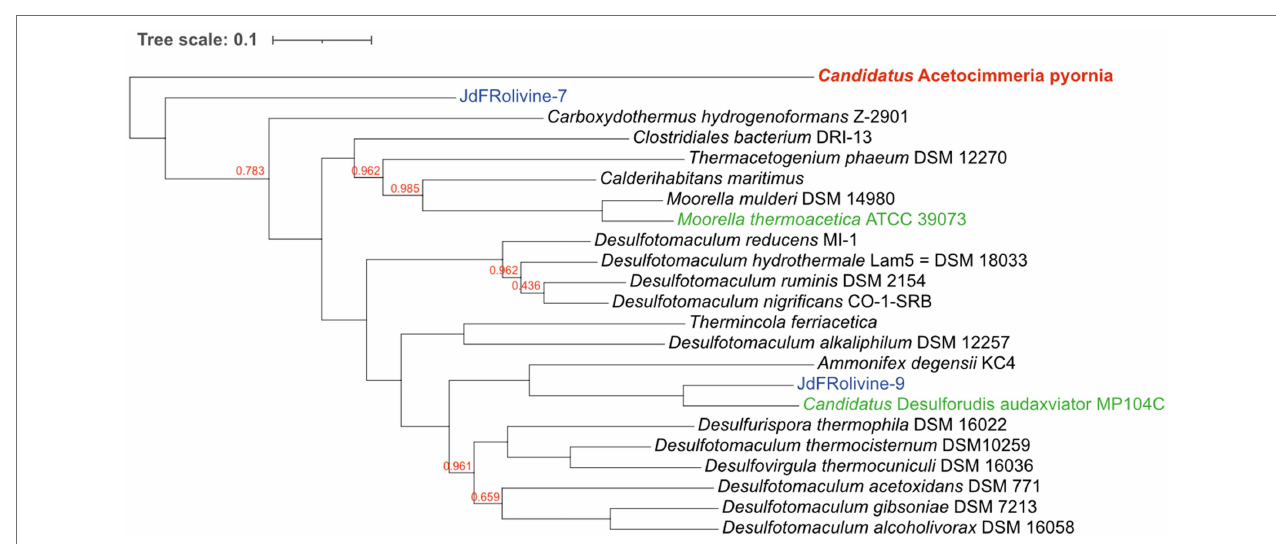
FIGURE 1 | Whole genome phylogenetic tree for Ca. Acetocimmeria pyornia and closest genomic relatives. Branches with no bootstrap numbers are 1.000. Branches whose bootstrap numbers are less than 1.000 are indicated on the branch.